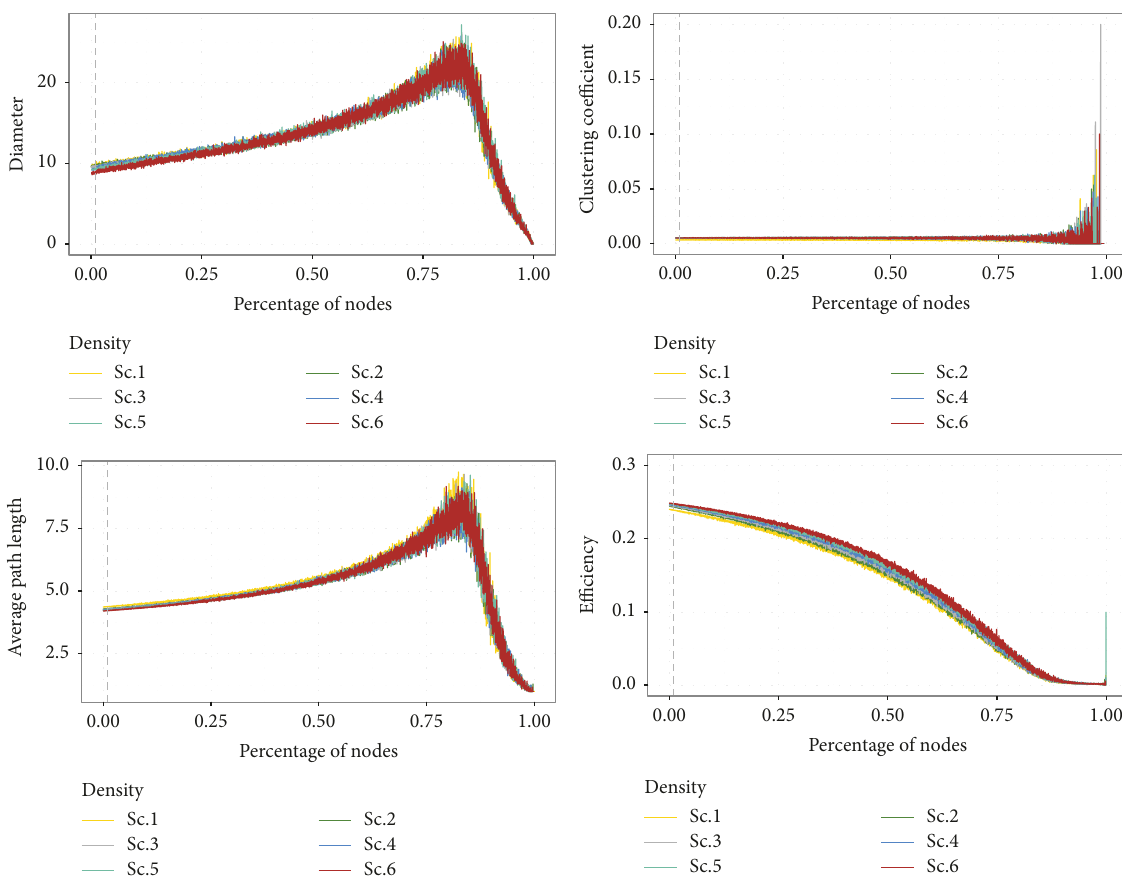
Figure 8: Resilience for simultaneous error simulations with progressive manipulation of the number of links in the network periphery. The dashed line is placed in correspondence with the rich-club size. All results are averaged over 10